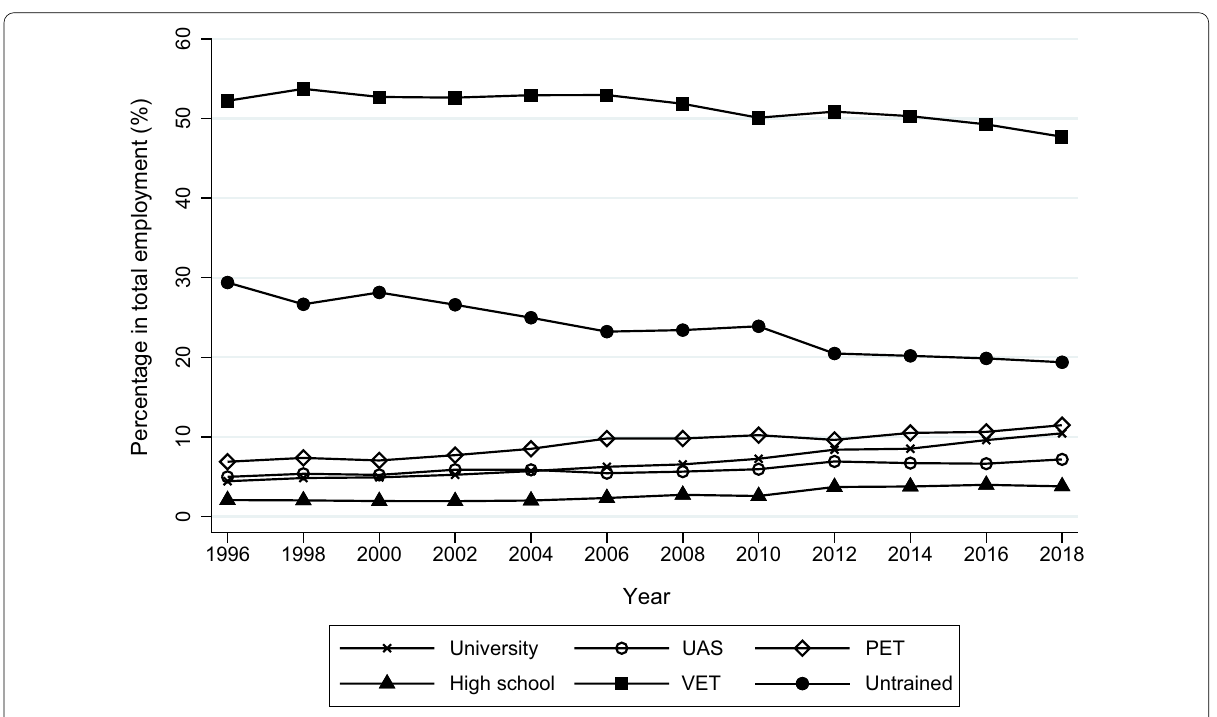
Fig. 1 Educational composition over time